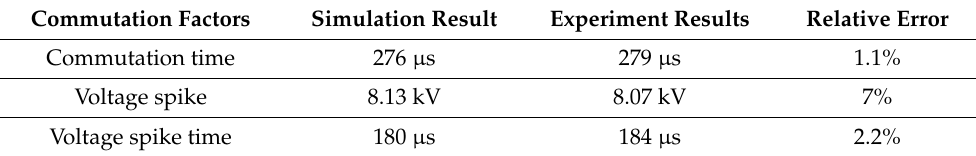
Table 3. The comparison between the simulation and the experiment under 60